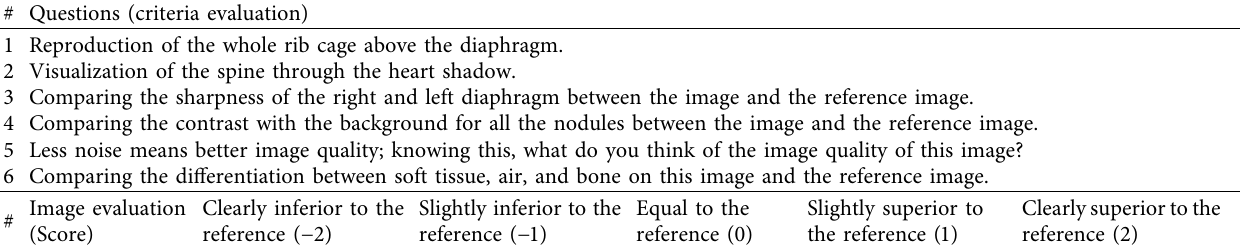
Table 2: Criteria evaluation tool in the visual grading analysis for evaluation